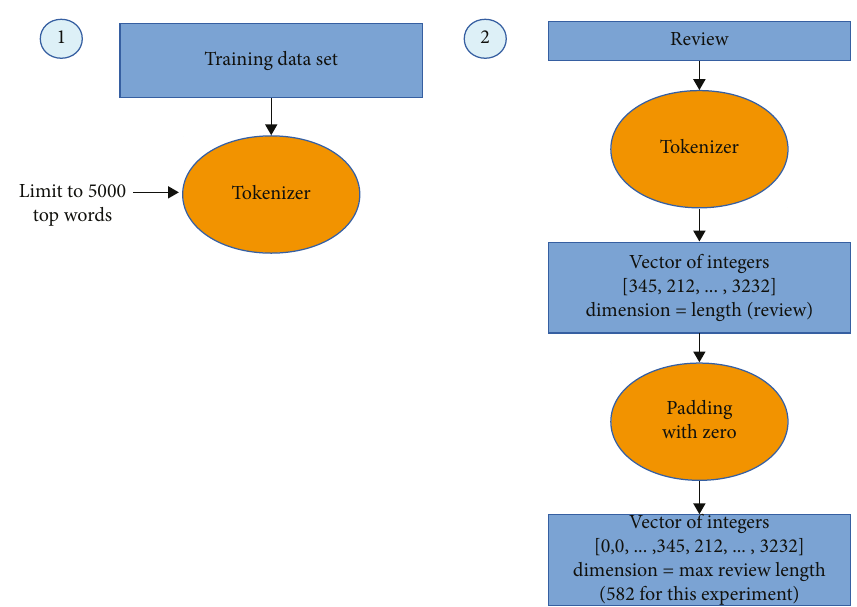
Figure 3: Converting review to fi xed-length